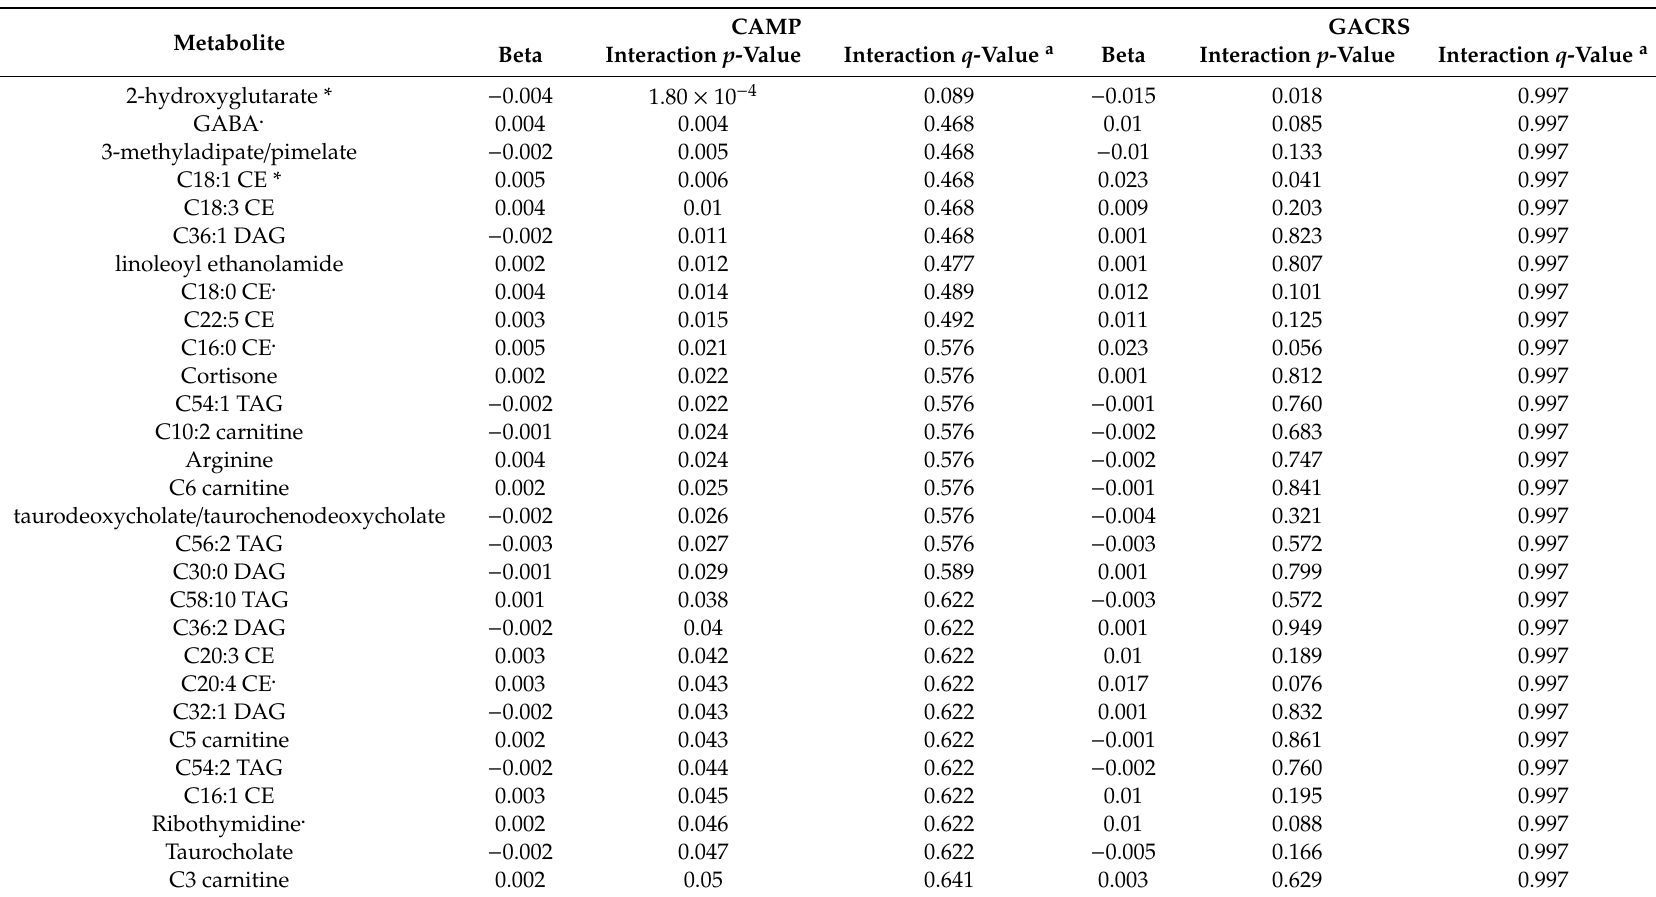
Table 3. Metabolites that had a significant interaction with age in the determination of BDR in CAMP and their interaction e ff ect in the replication cohort, GACRS. Only the 29 metabolites (of 38 significant) that were measured in GACRS are shown